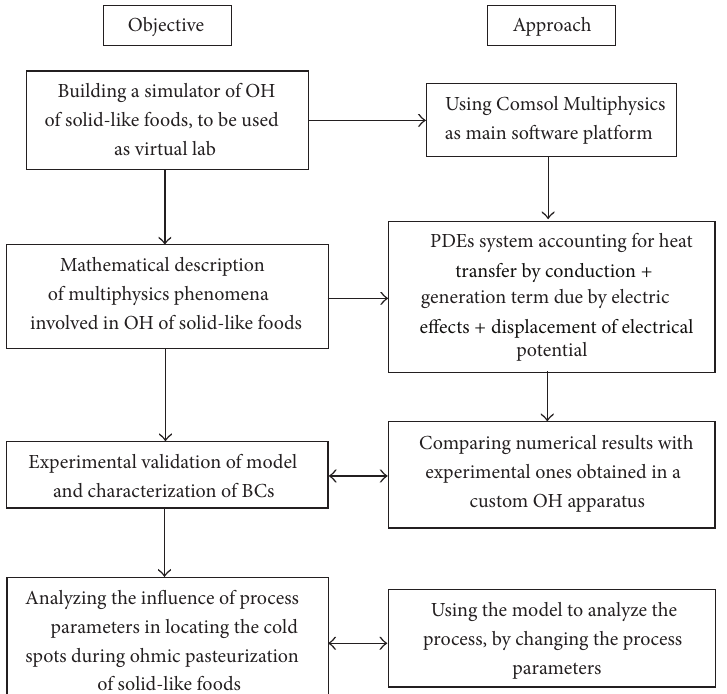
Figure 1: Flow-sheet of mutual connections existing between the objective and the approach used in the present work.